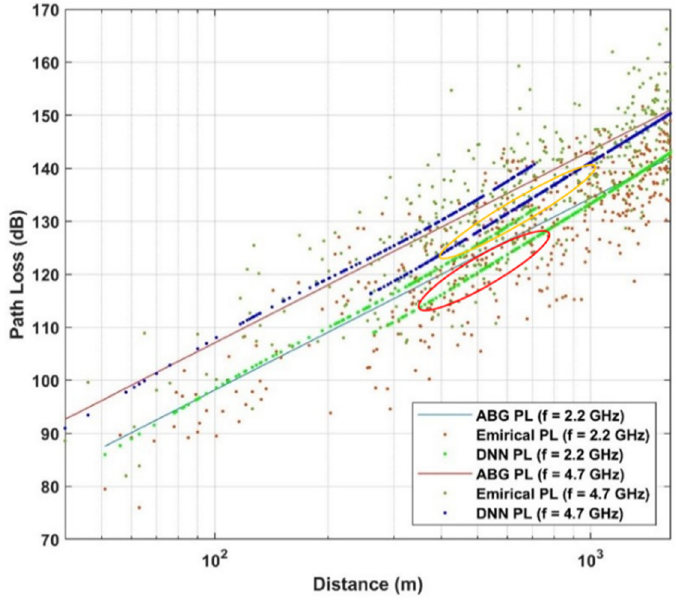
Figure 10. Path loss models and empirical data for low 5G band.